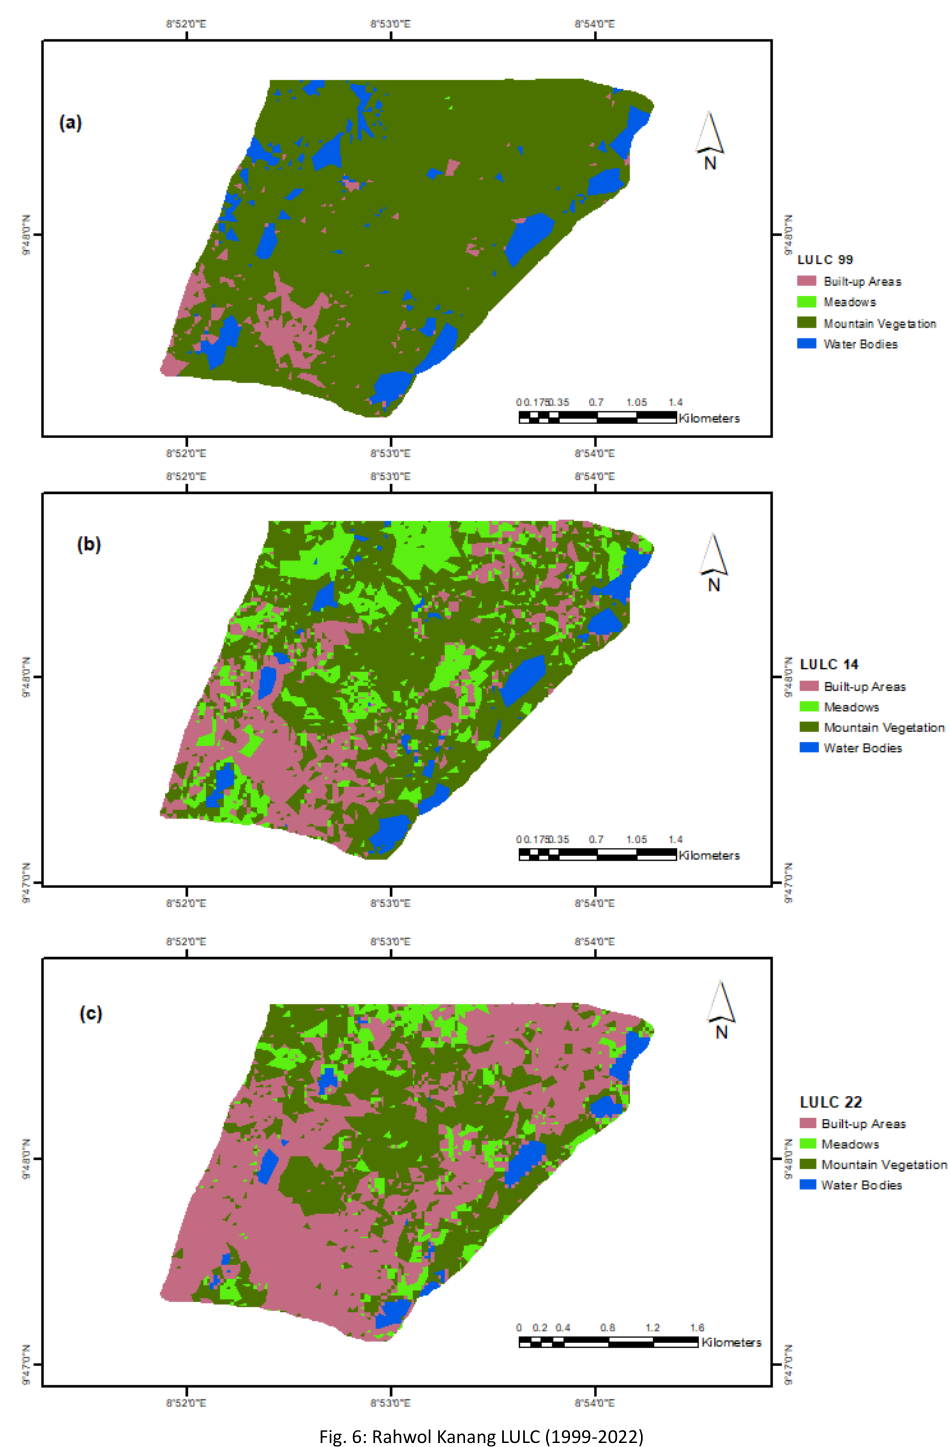
Fig. 6: Rahwol Kanang LULC (1999‐2022)